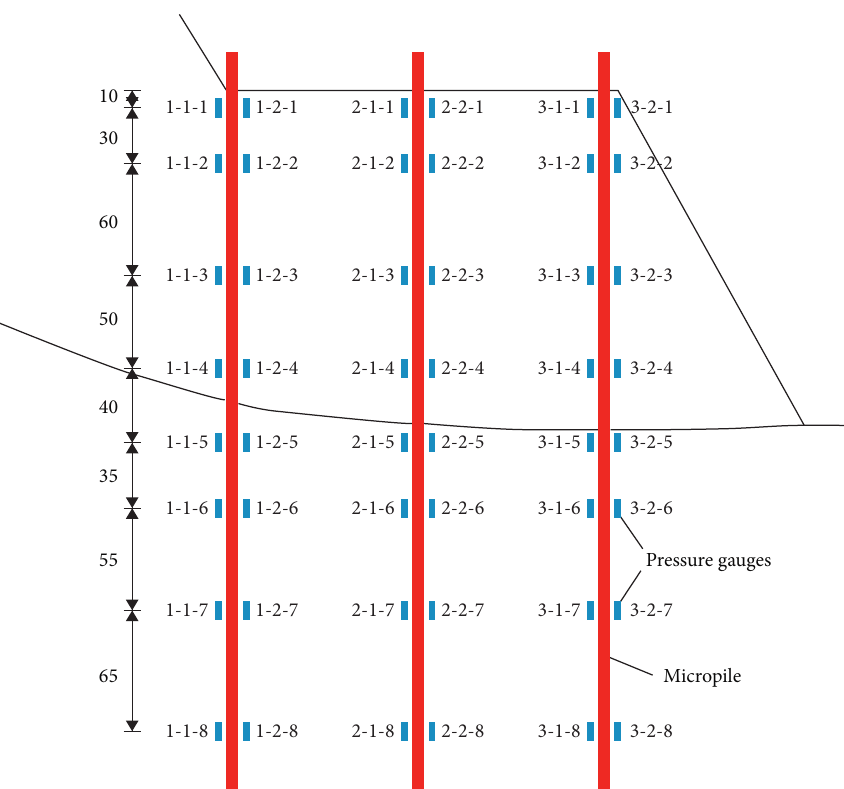
Figure 7: Distribution of the pressure gauges in vertical direction along the pile (unit: